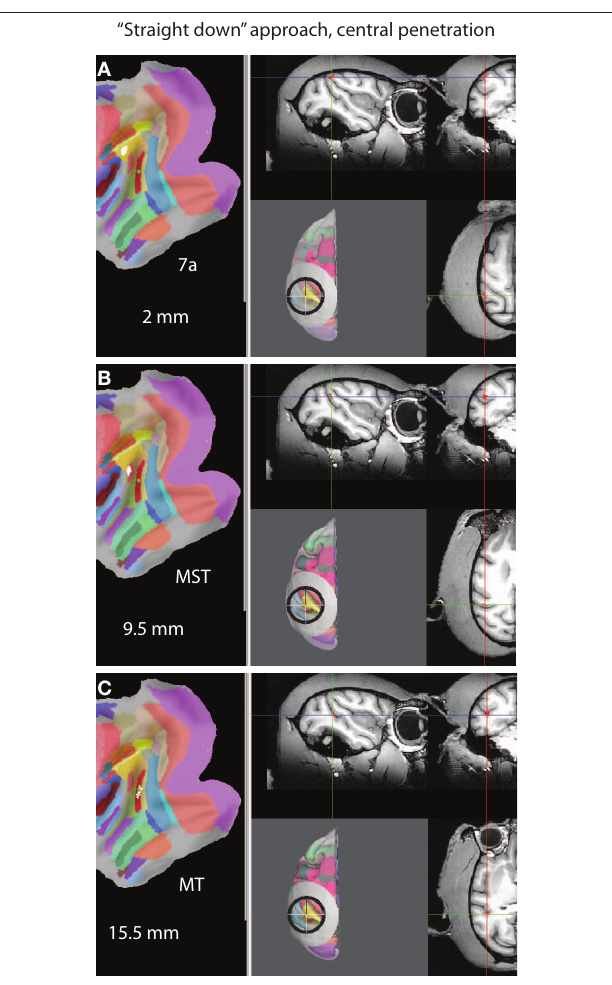
Figure 10 | A virtual electrode trajectory along the symmetry axis of the “straight down” approach (elevation and tilt of zero). (A) Hitting area 7a at a depth of 2 mm. (B) Hitting MST at a depth of 9.5 mm. (C) Hitting MT at a depth of